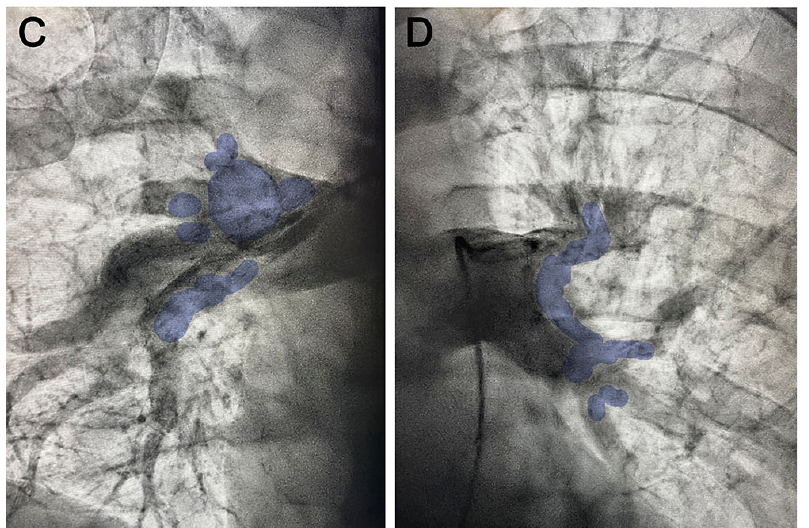
Figure 3. Right ( A ) and left ( B ) pulmonary artery angiography showing bilateral embolisms (colored markings in ( C , D ).